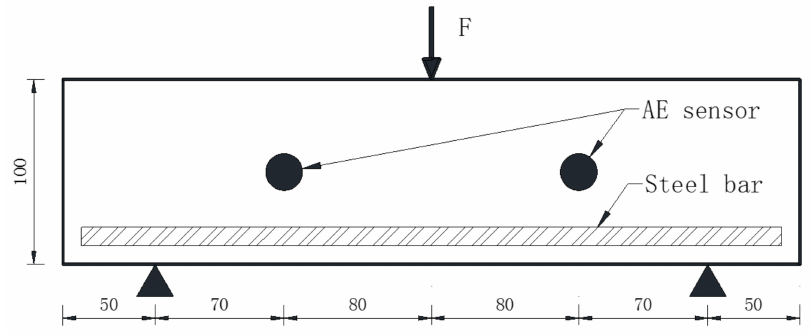
Figure 7. Loading and AE sensors layout